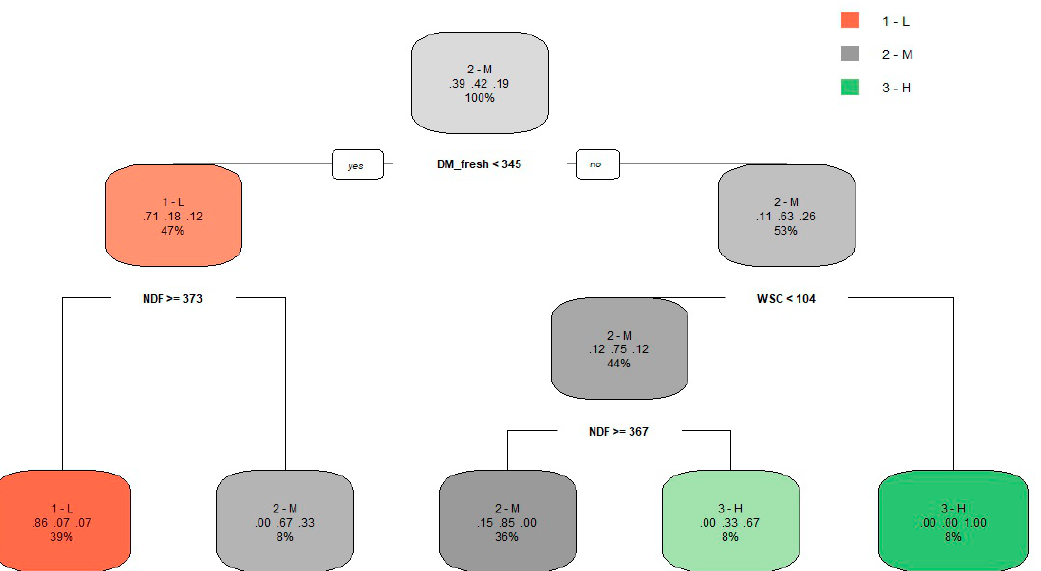
Figure 3. Dry matter losses (DML) of whole-plant maize (WPM) silage based on a decision tree algorithm. Data inside each node are (top to bottom): prevalent DML-class (increasing % of samples belonging to the class raising the intensity of color); fractions of the three DML classes within the node; percentage of original data set explained. 1—L-class, DML < 3%; 2—M-class, DML 3–7%;